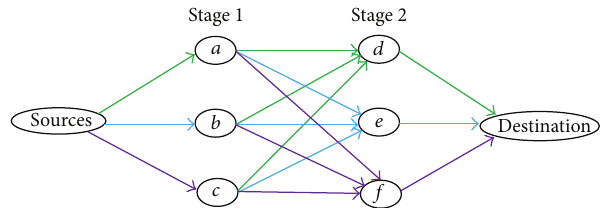
Figure 1: Single and double switch faulty situations in MIN.